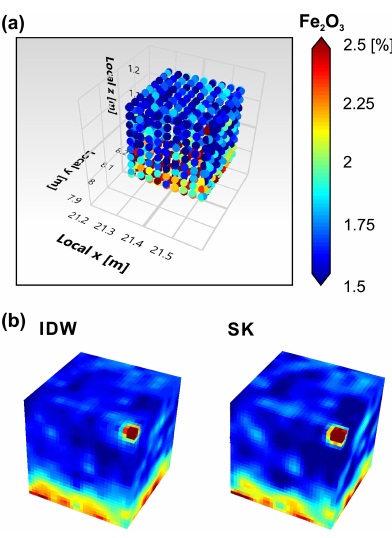
Figure 4. (a) Fe 2 O 3 measurement locations on the cube faces of OSB1_c and on the rock samples extracted from the cube. The di- ameter of one point is 1.2cm, which corresponds to the beam di- ameter of the pXRF measurement device. (b) Visual representation of the inverse distance weighting (IDW) and simple kriging (SK) realization of the 3D scalar field of Fe 2 O 3 , using the discrete points displayed in (a) as known data points.